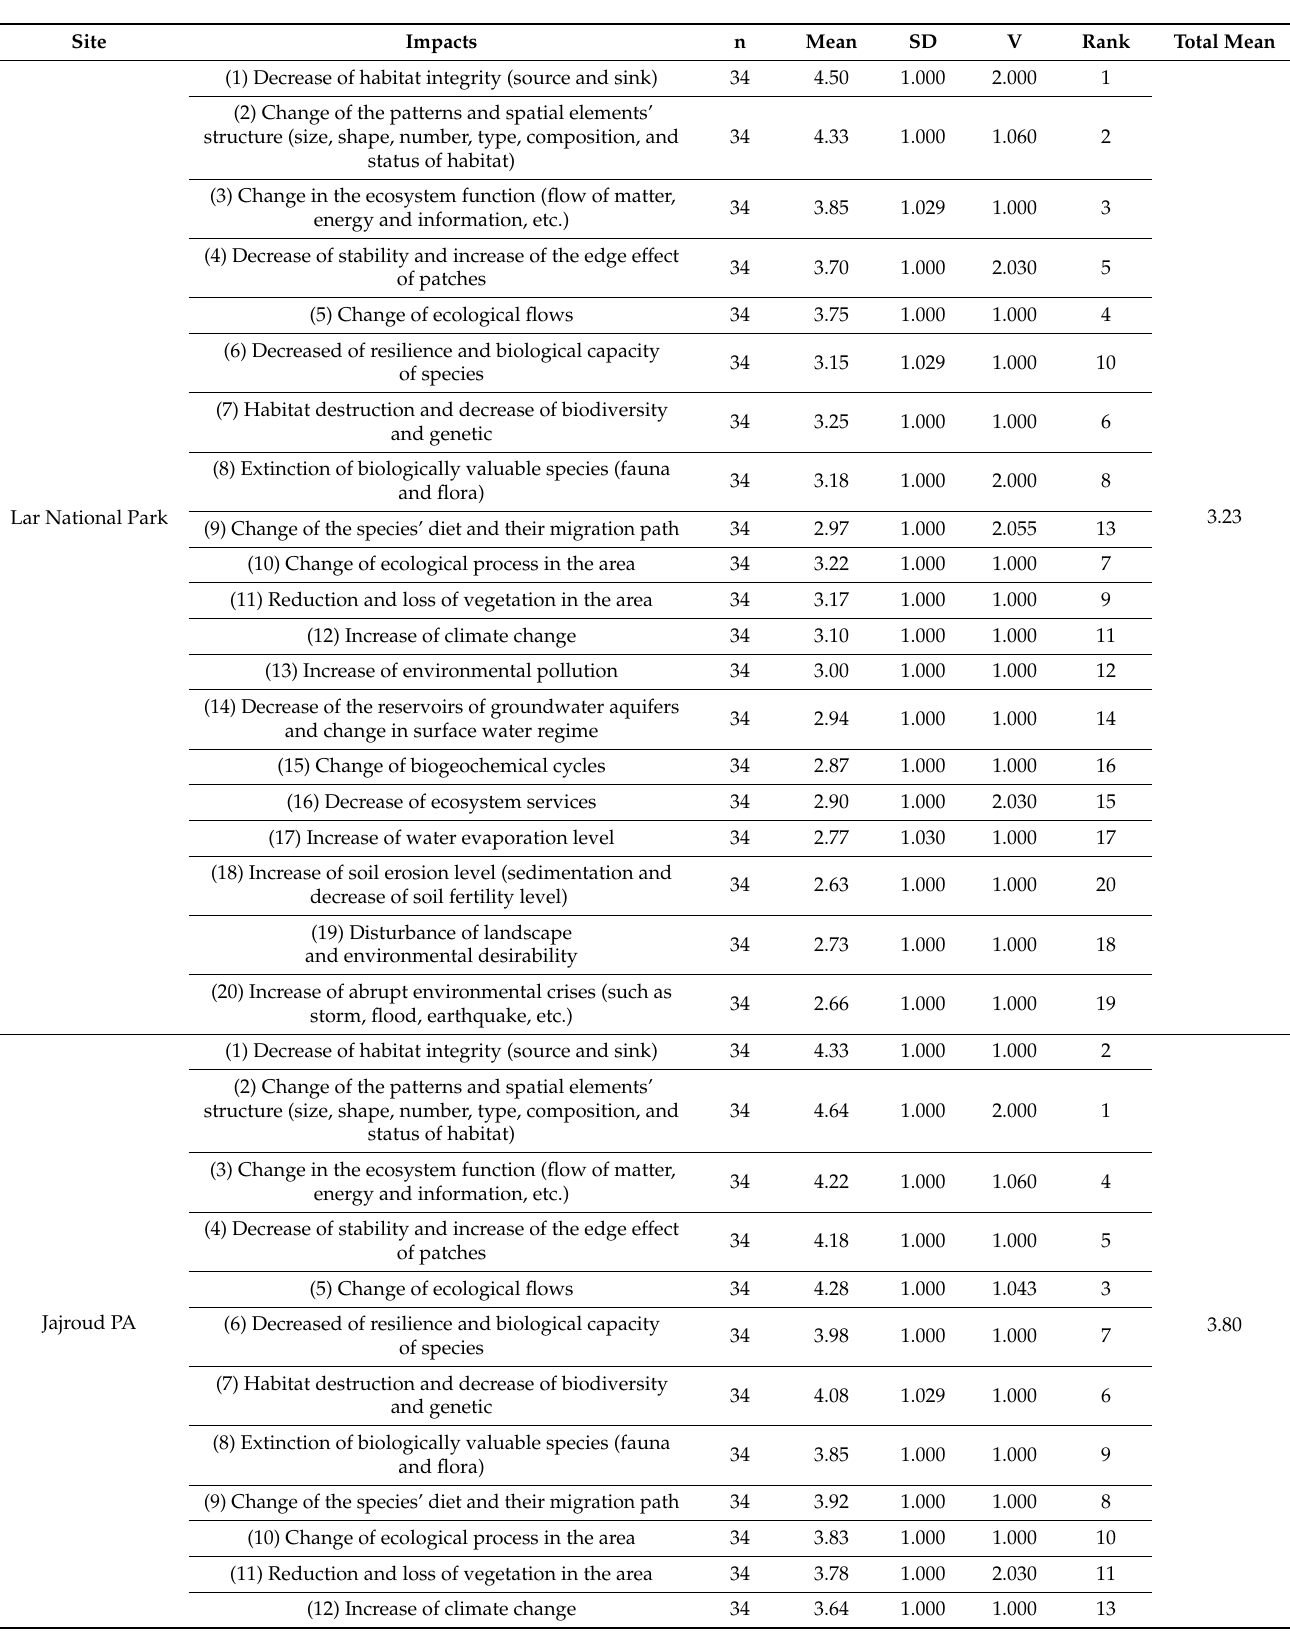
Table 6. Impacts of habitat fragmentation in the studied areas (results of round 3 of Delphi method). Site Impacts n Mean SD V Rank Total